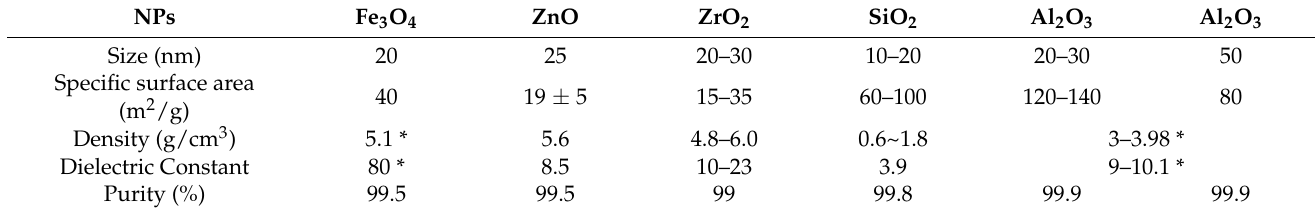
Table 2. Characteristics of the